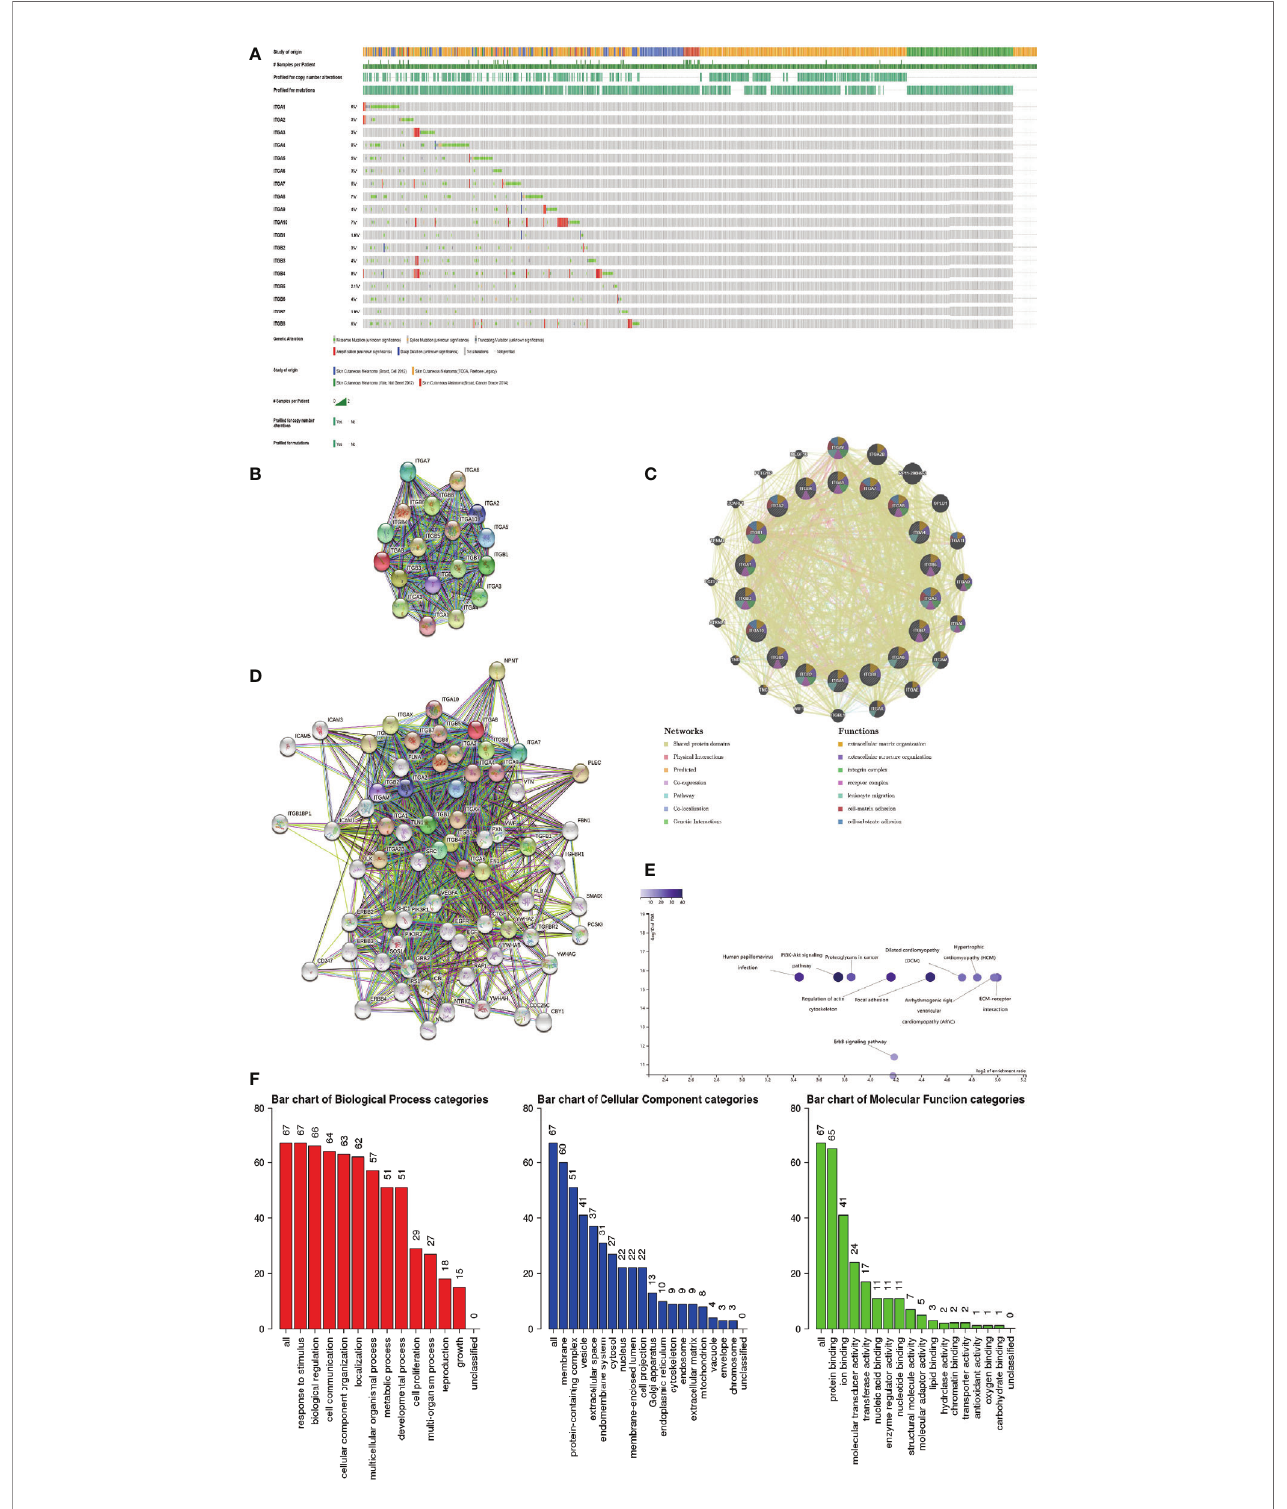
FIGURE 9 | (A) Summary of genetic alterations in different integrin subunits in SKCM. (B, C) Protein-protein interaction network of different integrin subunits. (D) Gene-gene interaction network of different integrin subunits and 48 most frequently altered neighboring genes. (E, F) Enrichment analysis of different integrin subunits and 48 most frequently altered neighboring genes in SKCM (Webgestalt). (E) Bar plot of KEGG enriched terms. (F) Bar plot of GO enrichment in biological process terms, cellular component terms, and molecular function